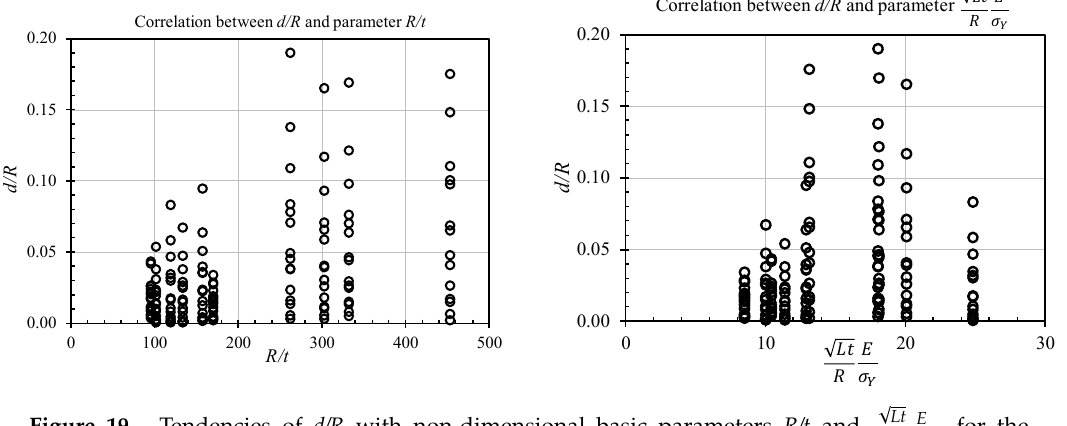
Figure 19. Tendencies of d/R with non-dimensional basic parameters R/t and √ ring-stiffened cylinder.